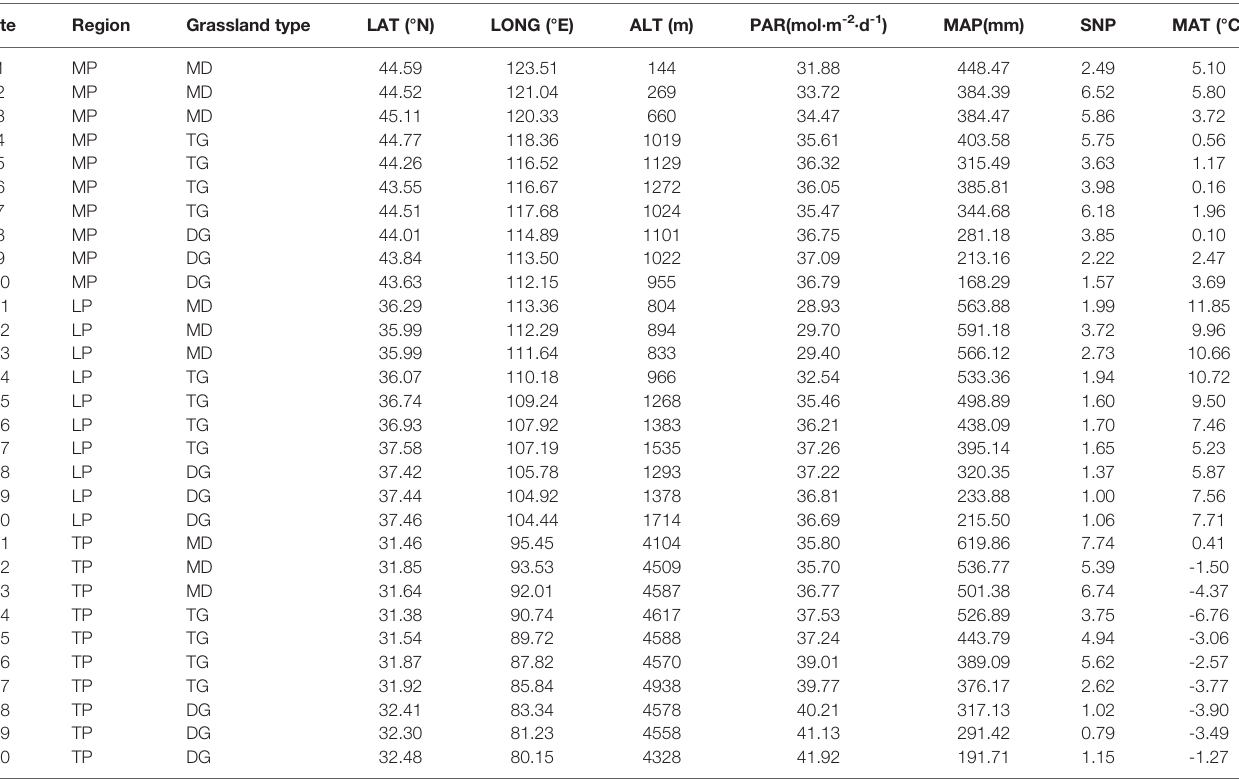
FIGURE 1 | Site locations in northern grassland transects. They were chosen involving three major plateaus in the northern hemisphere, as Mongolia Plateau (MP), Loess Plateau (LP) and Tibet Plateau (TP), and three grassland types of meadow, typical grassland and desert grassland. TABLE 1 | Geographical locations and environmental conditions of studied sites in northern hemisphere grassland